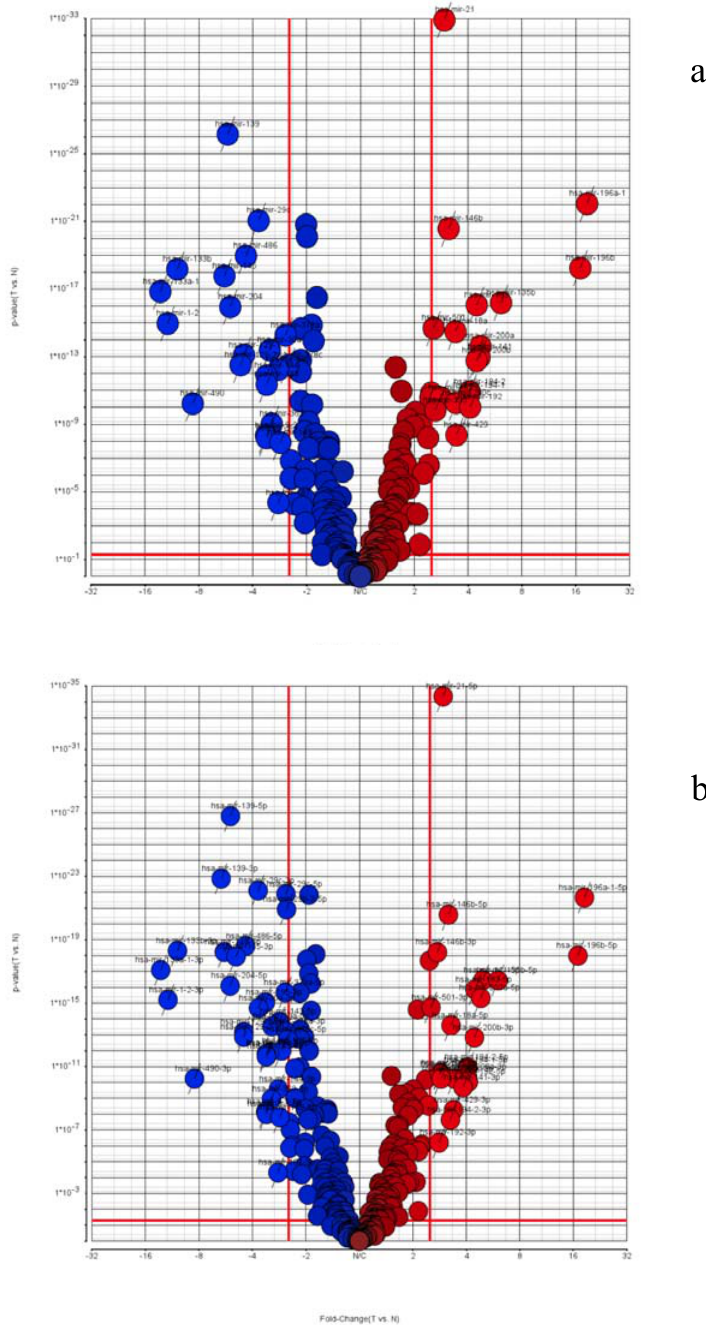
Figure 5. Volcano plot of combined miRNA expression and separate 5p-arm/3p-arm miRNA expression in TCGA (The Cancer Genome Atlas) gastric cancer tissues. miRNA expression data of TCGA stomach adenocarcinoma (STAD) were retrieved and re-analyzed using the comprehensive arm feature annotated miRNA list. The miRNA expression information of gastric cancer tissues is illustrated here by calculating the mean expression level from TCGA samples. Following analysis of variance (ANOVA) in the Partek software package, the volcano plot is displayed for selecting differentially expressed miRNA genes. ( a ) Precursor miRNAs gene loci expression by combining the 5p-arm and 3p-arm miRNAs together for analysis; ( b ) 5p-arm and 3p-arm miRNAs tabulated separately for their expression and